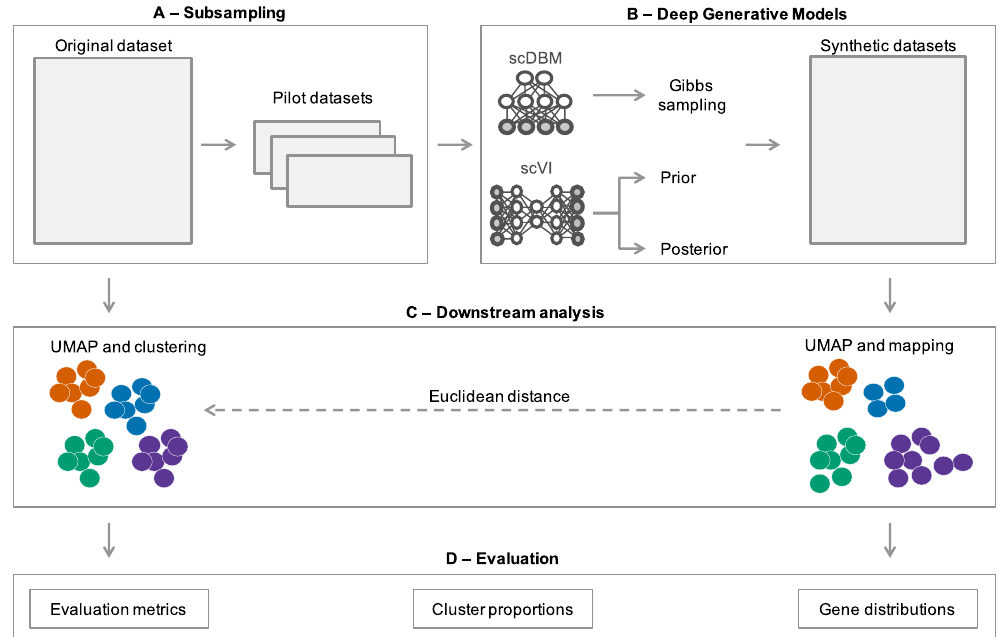
Figure 1. Design for evaluating the performance of deep generative models with small pilot datasets: ( A ) Take a sub-sample from an original dataset to obtain pilot data with known ground truth. ( B ) Train the deep generative approaches on the pilot dataset and generate synthetic data in the original data size. ( C ) Apply dimensionality reduction with UMAP and Seurat clustering to the original data and map each synthetic observation to the closest observation from the original data, thus getting a cluster assignment. ( D ) Evaluate the quality of synthetic samples based on the Davies–Bouldin index, adjusted Rand index, cluster proportions, and distributions per gene. The complete analysis is performed for different sizes of pilot datasets (384, 768, 1152, 1536, 1920, and 2304 cells) and repeated 30 times for each